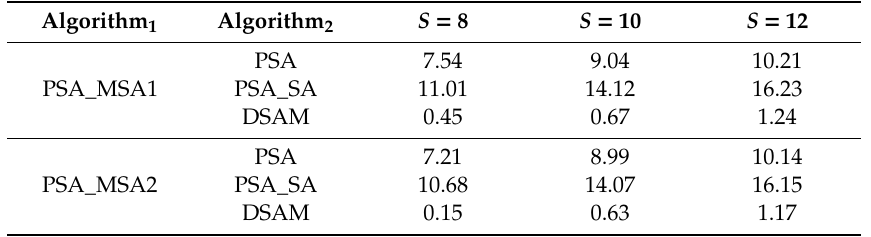
(cid:48) Table 3. Comparison results ( ∆ PCC %) of di ff erent SPM models for the synthetic data set. Table 3. Comparison results ( Δ PCC' %) of different SPM models for the synthetic data set.